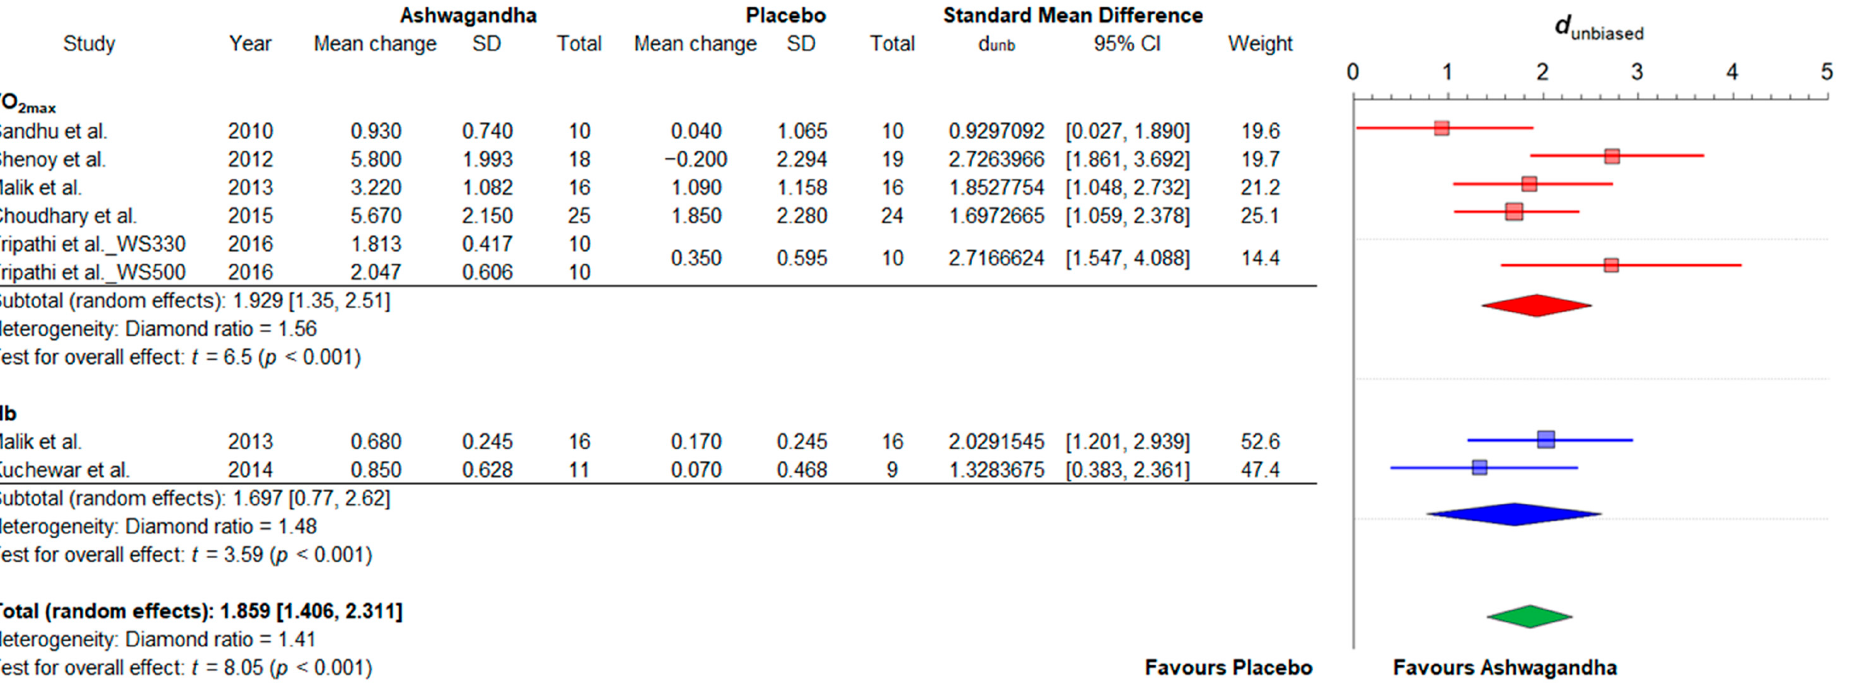
Figure 6. Forest plot depicting the standardized mean differences from the meta-analysis of studies comparing groups with Ashwagandha or placebo on cardiorespiratory fitness. Colored squares represent the d unb for individual trials, while colored and green polygons depict the meta-analytic d unb for the indicated subgroups and for the overall (total) results, respectively. Horizontal lines represent the 95% confidence intervals for the data. Hb: blood hemoglobin concentration; VO 2max : maximum oxygen uptake; WS330: Withania somnifera 330 mg; WS500: Withania somnifera 500 mg.